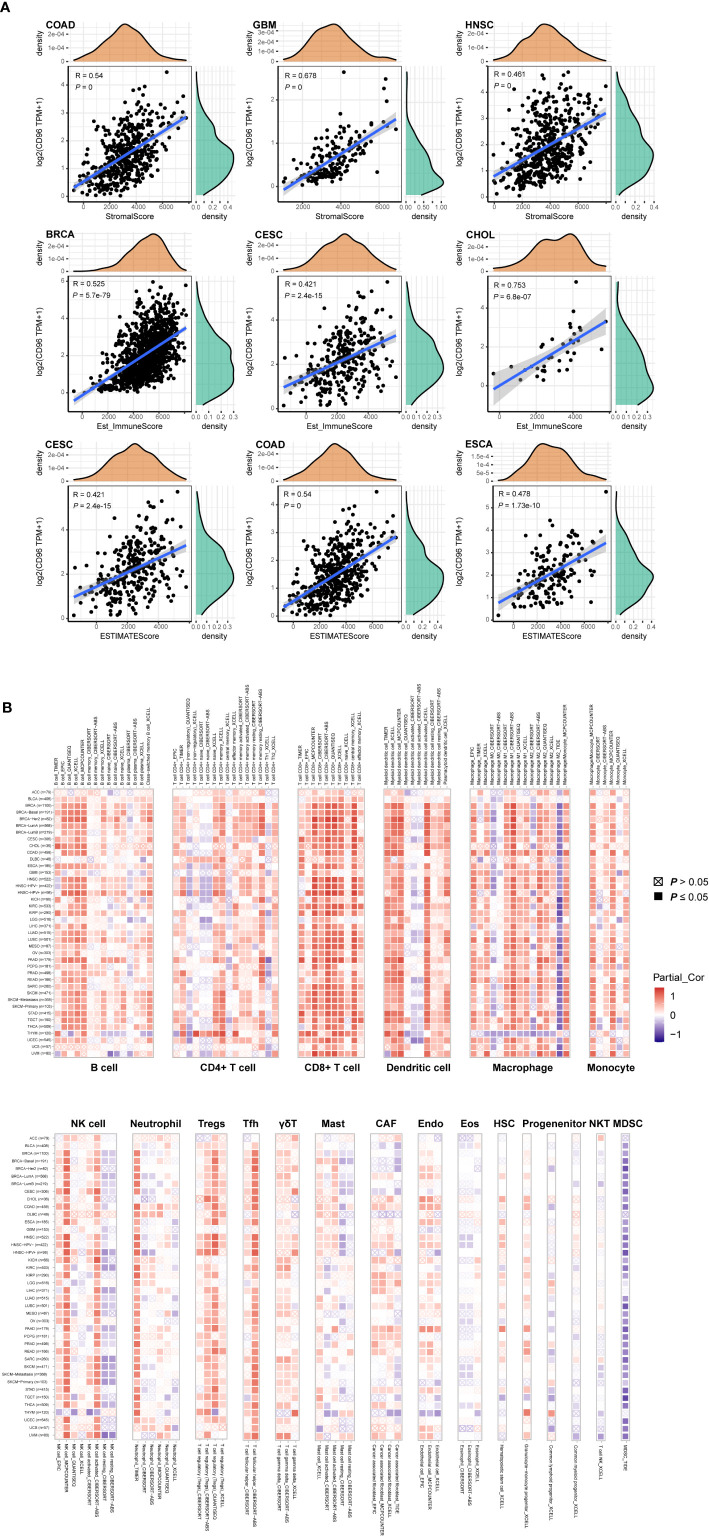
Associations of CD96 expression to tumor purity and immune infiltration. (A) Top three scatter plots of correlation between CD96 and stromal score, immune score, ESTIMATE score in various cancers. (B) The correlations of CD96 expression and immune infiltration in cancers.